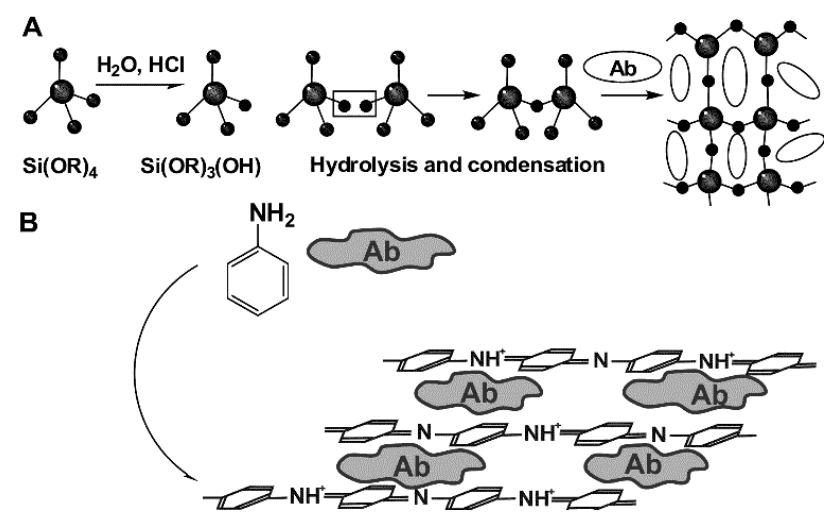
Figure 4. Physical Ab immobilization by sol-gel immobilization ( A ) and entrapment in electropolymerized film ( B ).